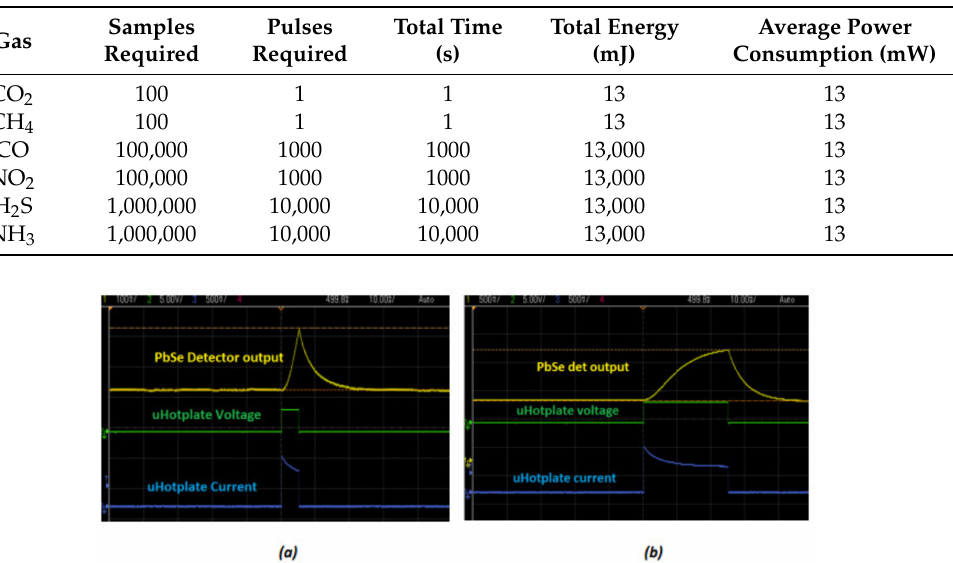
Figure 13. ( a ) System output with hotplate pulsed at 5 ms and ( b ) System output with hotplate pulsed at 25